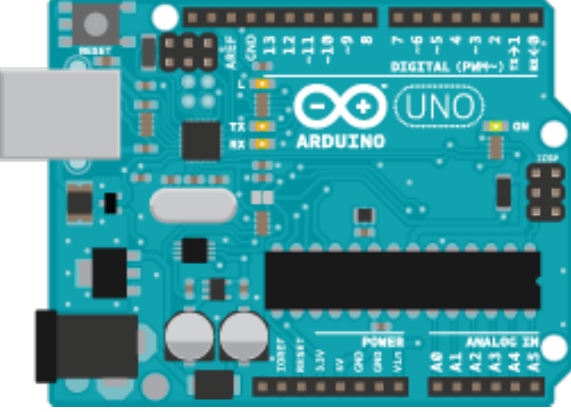
Figure 1. Arduino